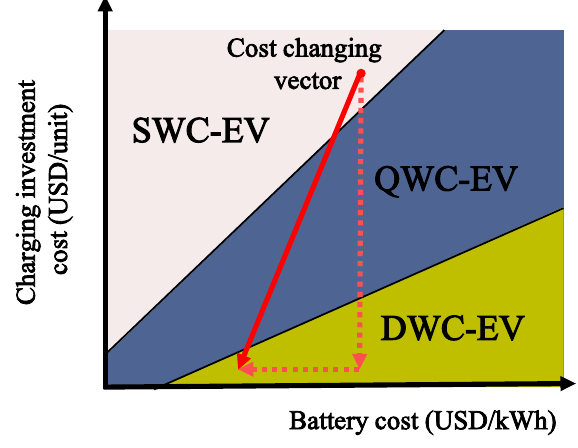
Figure 14. Future cost